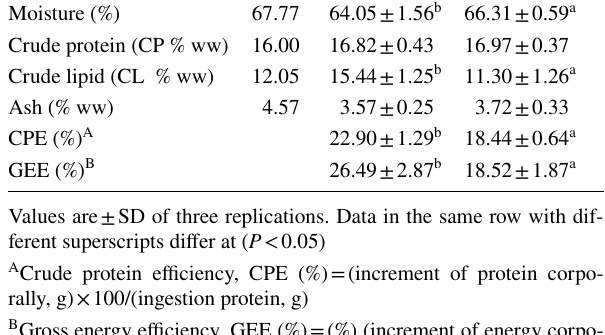
Table 5 Body composition and retention of sharpsnout sea bream fed with wheat diet (CON) and citrus pulp diet (CP)